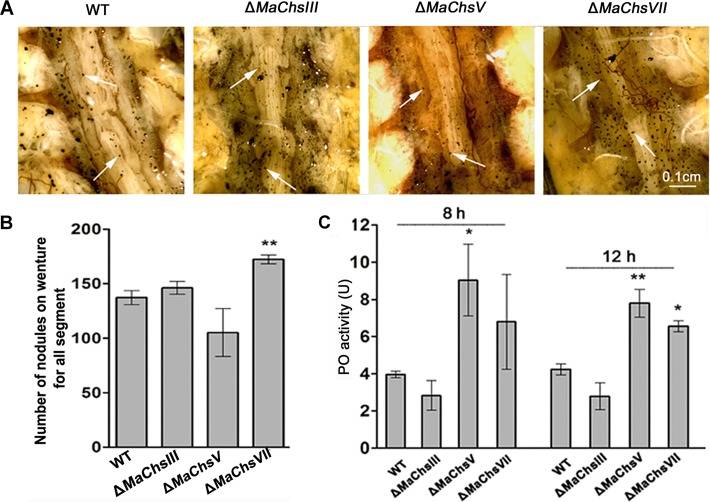
Determination of nodulation and phenoloxidase (PO) activity in locust.(A) The nodule formation in insect inner body walls at 12 h after injection. Arrows indicate typical nodules. (B) The number of nodules after injection at 12 h on insect inner body walls. (C) Phenoloxidase (PO) activity in hemolymph at 8 h and 12 h after inoculation with various strains. A single asterisk above bars denotes significant difference, P < 0.05; double asterisks above bars denote significant difference, P < 0.01. Error bars indicate standard errors of three trials.